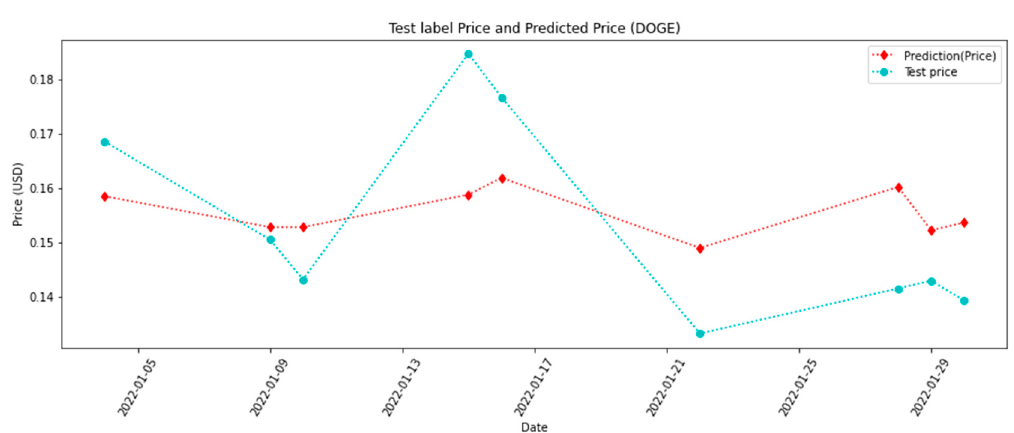
Figure 15. The plot of tested vs. predicted trend in Bitcoin.